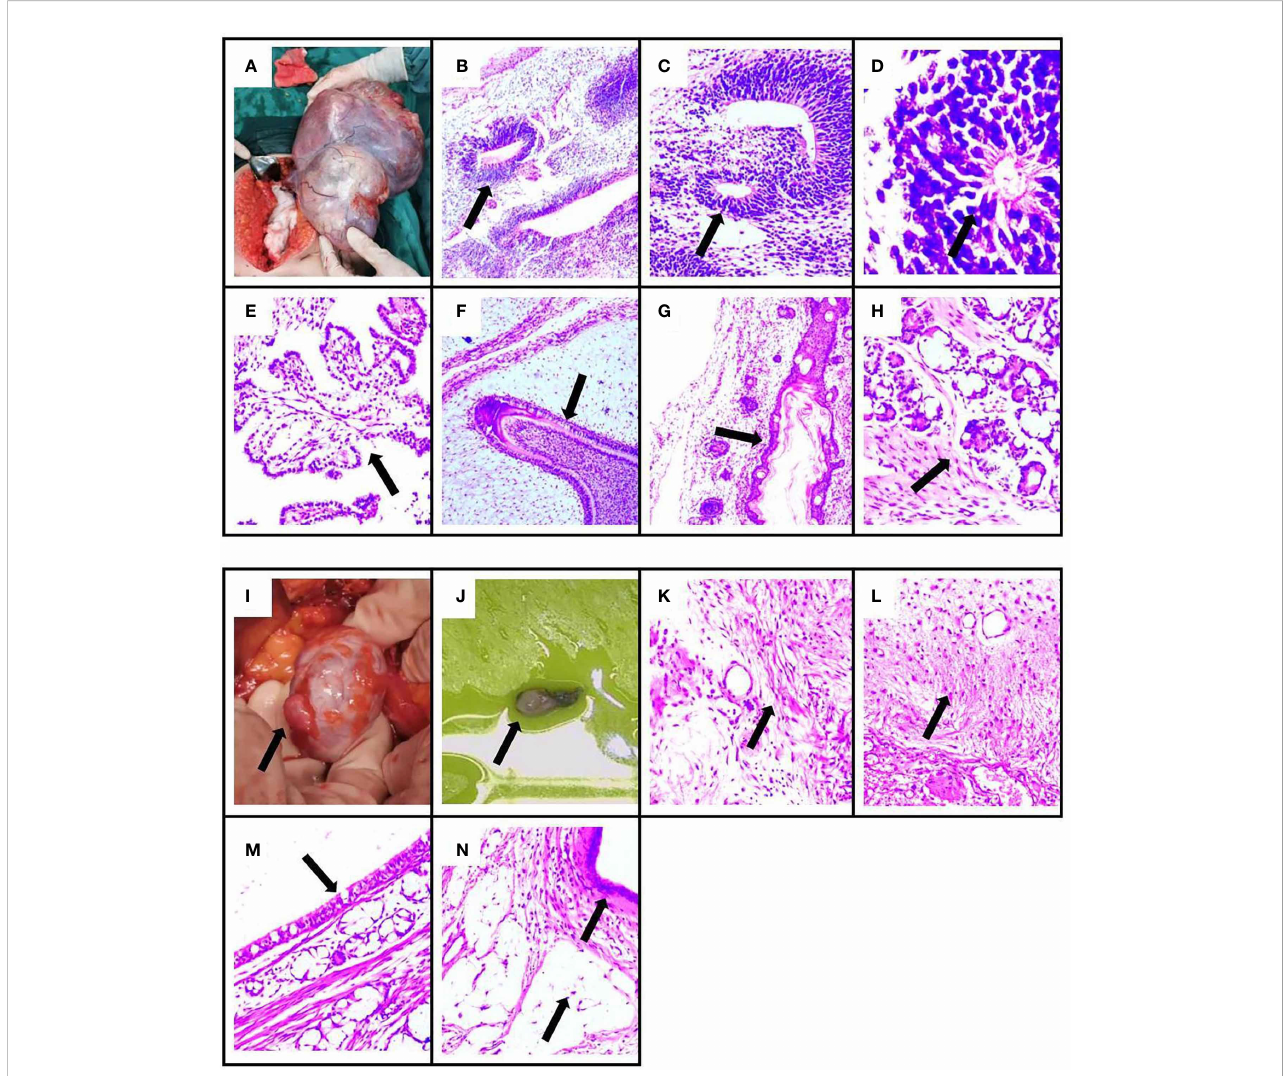
FIGURE 3 The pathology results and surgical specimen of the patient. The specimen showed immature ovarian teratoma, consisting of neuroglia, primitive neural tube, infantile neural tissue, choroid plexus tissue, naive enamel organ, epidermis, hair follicle, and salivary gland tissue by H&E staining. The arrows indicate lesions in (B – H) . (B) Neuroglia. (C) Primitive neural tube. (D) Infantile neural tissue. (E) Choroid plexus tissue. (F) Naive enamel organ. (G) Epidermis and hair follicle. (H) Salivary gland tissue. (A) The immature ovarian teratoma after surgical resection. The specimen showed mature ovarian teratoma, consisting of mature neuroglial, mature brain tissue, respiratory epithelium, mature adipose tissue, and keratocysts by H&E staining. The arrows indicate lesions in (K – N) . (K) Mature neuroglial. (L) Mature brain tissue. (M) Respiratory epithelium. (N) Mature adipose tissue and keratocysts. (I, J) The mature ovarian teratoma after surgical